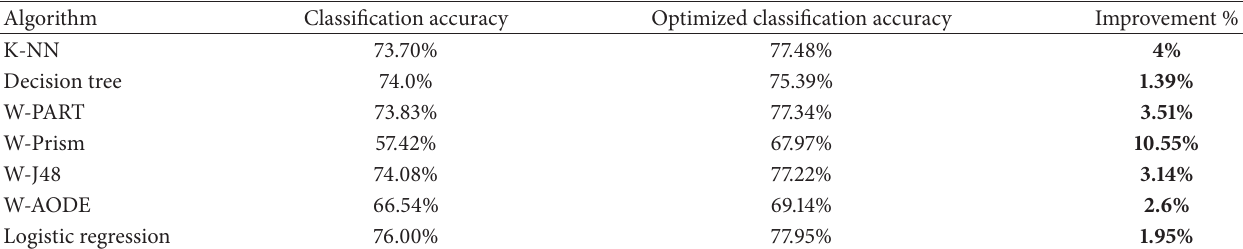
Table 12: Results of diabetes dataset: comparison of optimized classification accuracy using GMC model with simple classification using different